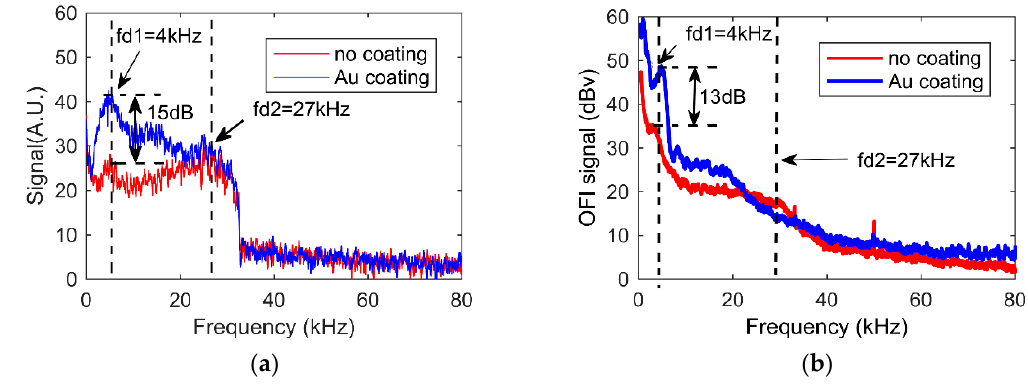
Figure 7. The OFI signal frequency spectra obtained in a 96 µm × 96 µm DF channel without coating (red) and with a gold coating on the rear interface (blue): ( a ) simulated spectra; ( b ) measured spectra.